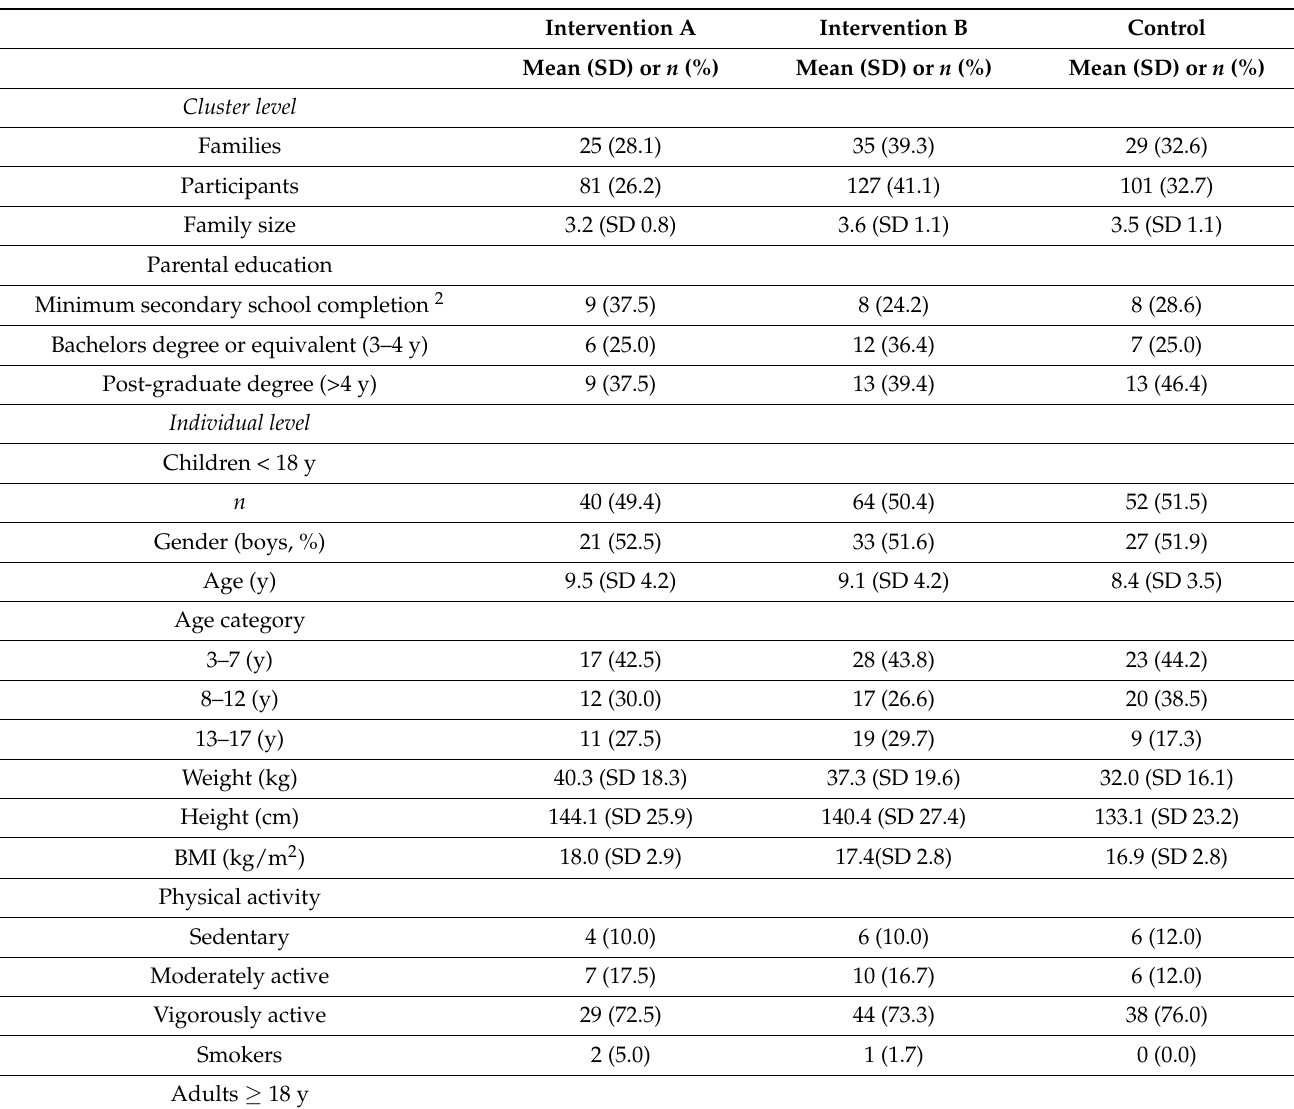
Table 2. Baseline characteristics at cluster and individual level 1